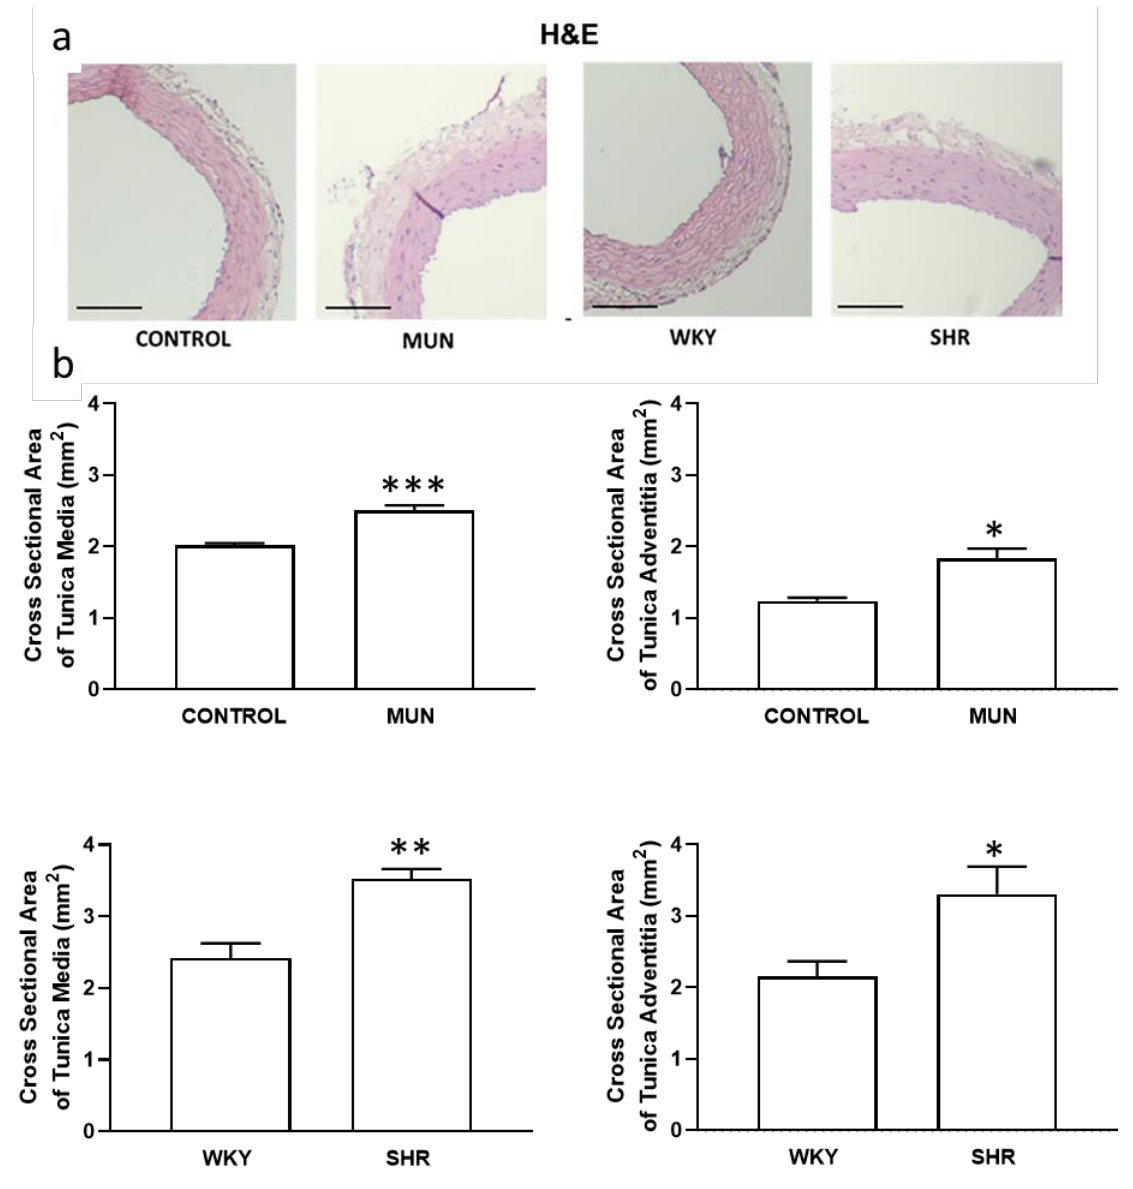
Figure 2. Histomorphometry of hypertensive (MUN and SHR) and normotensive (CONTROL and WKY) mesenteric wall. ( a ) Images were obtained from haematoxylin/eosin-stained arteries (scare bar = 300 µm). ( b ) Cross-sectional area of tunica media (right panel) and cross-sectional area of tunica adventitia (left panel). MUN, offspring exposed to maternal undernutrition during pregnancy; CONTROL, offspring from mothers fed ad libitum during pregnancy; SHR, spontaneously hypertensive rats; WKY, Wistar Kyoto rats. Values are mean ± s.e.m. from 6 rats of each group. Significant differences from the respective control rat: * p < 0.05; ** p < 0.01 *** p < 0.001. An increase in the connective tissue content was also observed, both in MUN and SHR, compared to their respective controls (CONTROL and WKY, respectively, Figure 3); the connective tissue increased in MUN near 2.1-fold relatively to CONTROL, whereas in SHR, it increased 1.5-fold relatively to WKY).